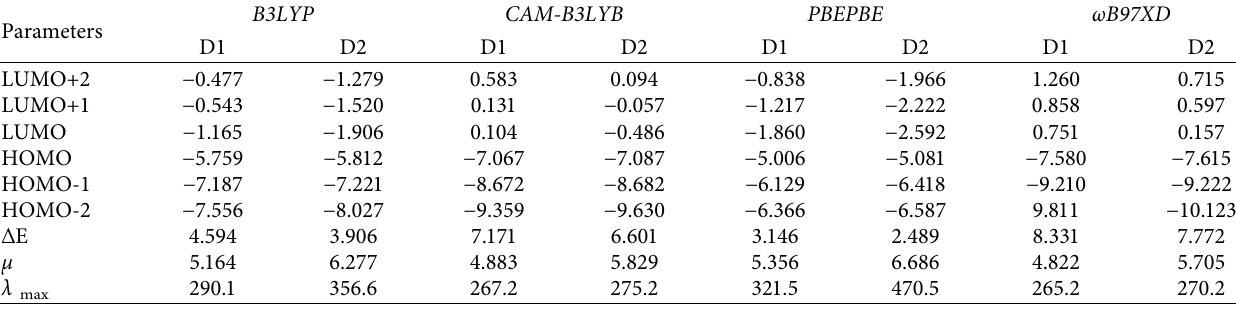
Table 2: The FMOs (eV), energy gaps ( ∆ E/eV), dipole moments ( µ /Debye), and absorption spectra maxima ( λ